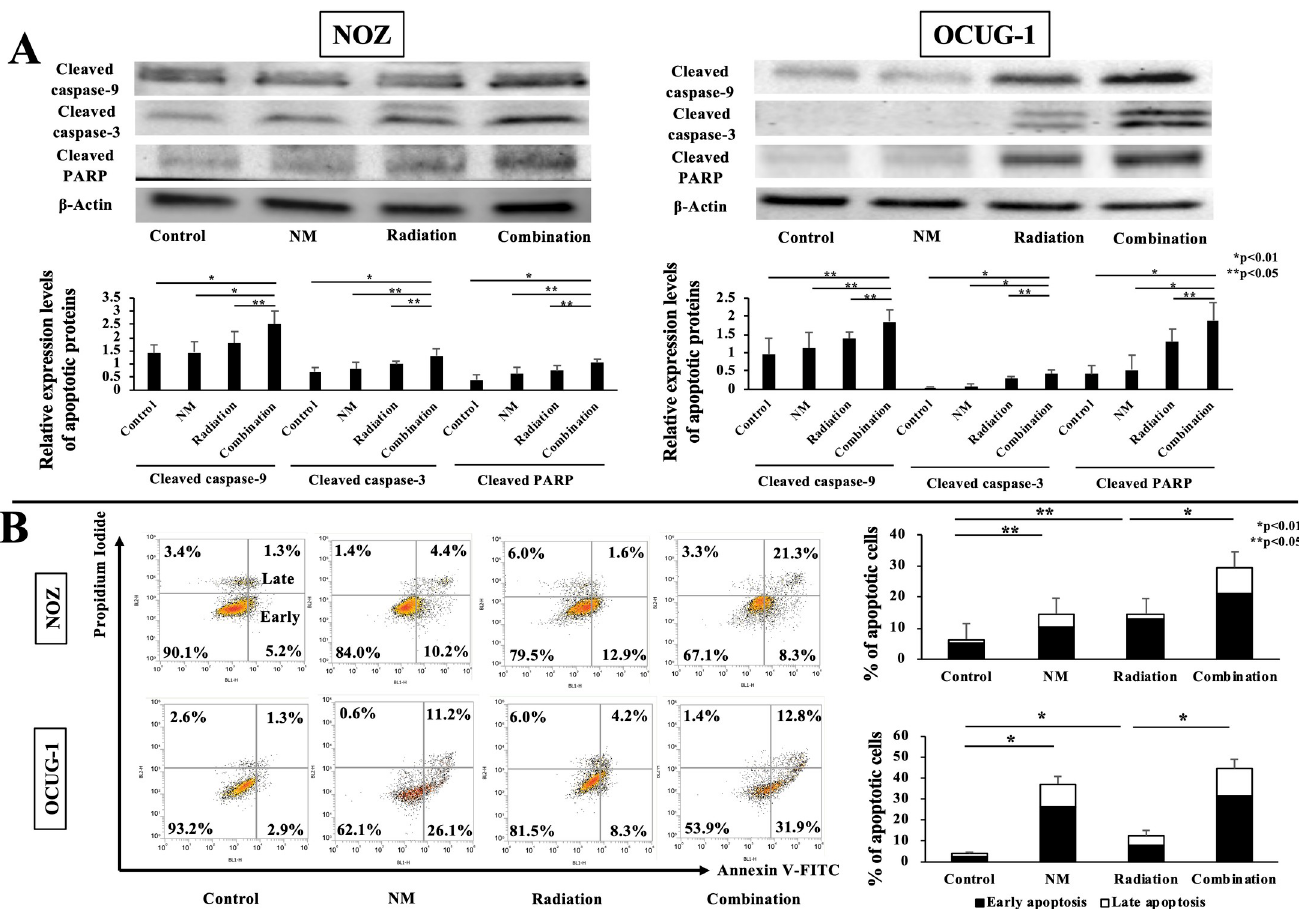
Fig 3. Quantification of apoptosis and apoptotic signals in vitro . (A) Western blotting results revealed that the expression levels of cleaved caspase-9, -3, and PARP in the combination group were higher than those in the other groups. (B) Annexin V/ FITC analysis by flow cytometry revealed that the proportions of early, late, and total apoptotic cells in the combination group were higher than those in the radiation group for NOZ and OCUG-1 cells (NOZ: early apoptosis: 21.3 ± 5.2% vs. 12.9 ± 1.9%, p < 0.05; late apoptosis: 8.3 ± 0.9% vs. 1.6 ± 0.2%, p < 0.01; total apoptosis: 29.5 ± 6.1% vs. 14.5 ± 2.1%, p < 0.01; OCUG-1: early apoptosis: 31.9 ± 2.3% vs. 8.3 ± 2.0%, p < 0.01; late apoptosis: 12.8 ± 2.2% vs. 4.2 ± 0.8%, p < 0.01; total apoptosis: 44.7 ± 4.4% vs. 12.5 ± 2.7%, p <